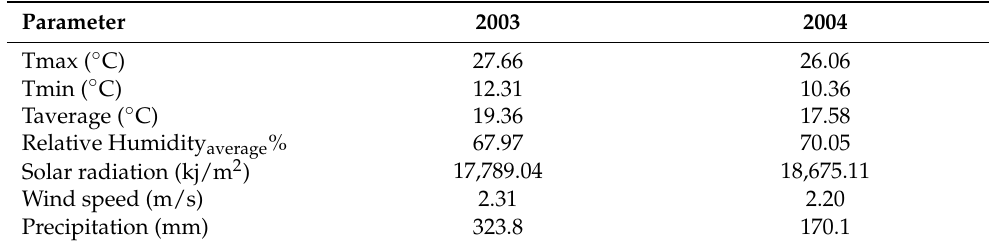
Table 1. The average values of the weather parameters for study period in 2003 and 2004 near Alvalade do Sado, Alentejo, Portugal. Parameter